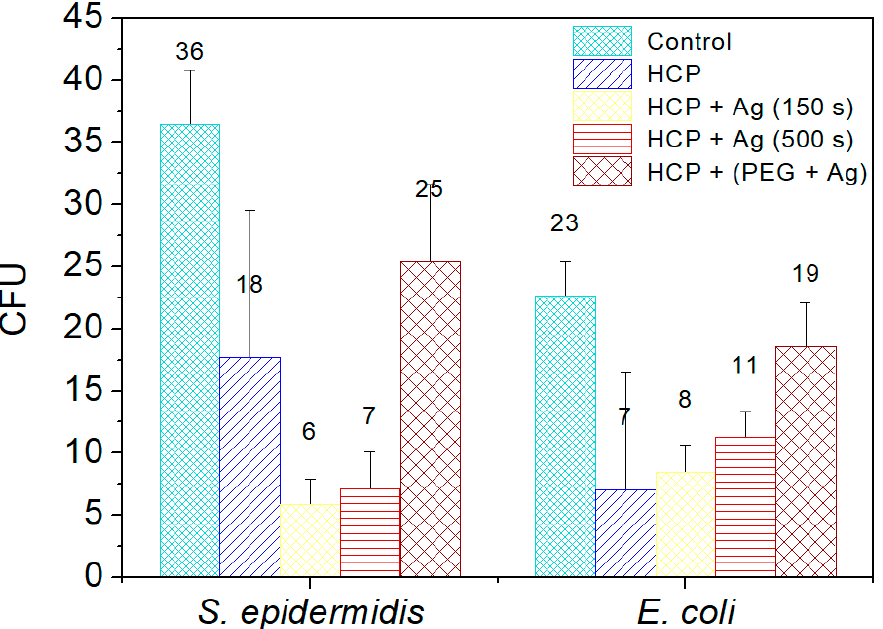
Figure 8. The numbers of colony-forming units (CFU) of S. epidermidis and E. coli , which were applied on the surfaces of the prepared samples of fluorinated ethylene propylene (FEP) for 2 h. The samples were tested after each phase of preparation: (1) honeycomb-like (HCP) structure formation; (2) sputtering of Ag layers for 150 s and 500 s on the HCP surface; (3) sputtering of Ag into polyethylene glycol (PEG) and embedding of the mixture into a solution in the HCP structure. Bacterial suspension incubated only with phosphate-buffered saline without any sample addition served as a control. The samples were done in triplicate.